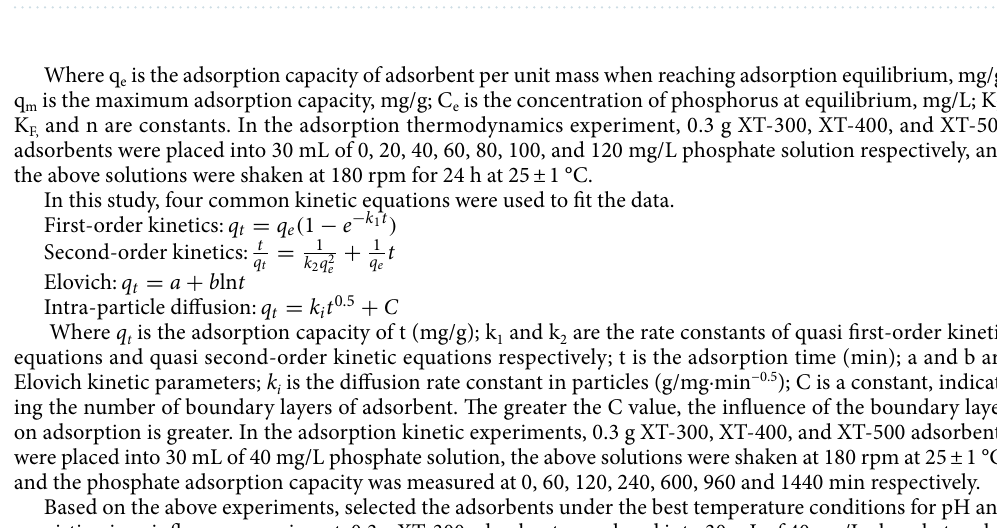
Table 1. Basic indicators of fruit and vegetable